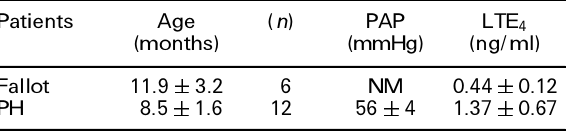
Table 1. Pulmonary arterial pressure and circulating leuko- triene E 4 levels in infant